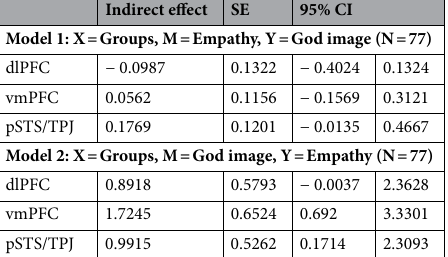
Indirect effect